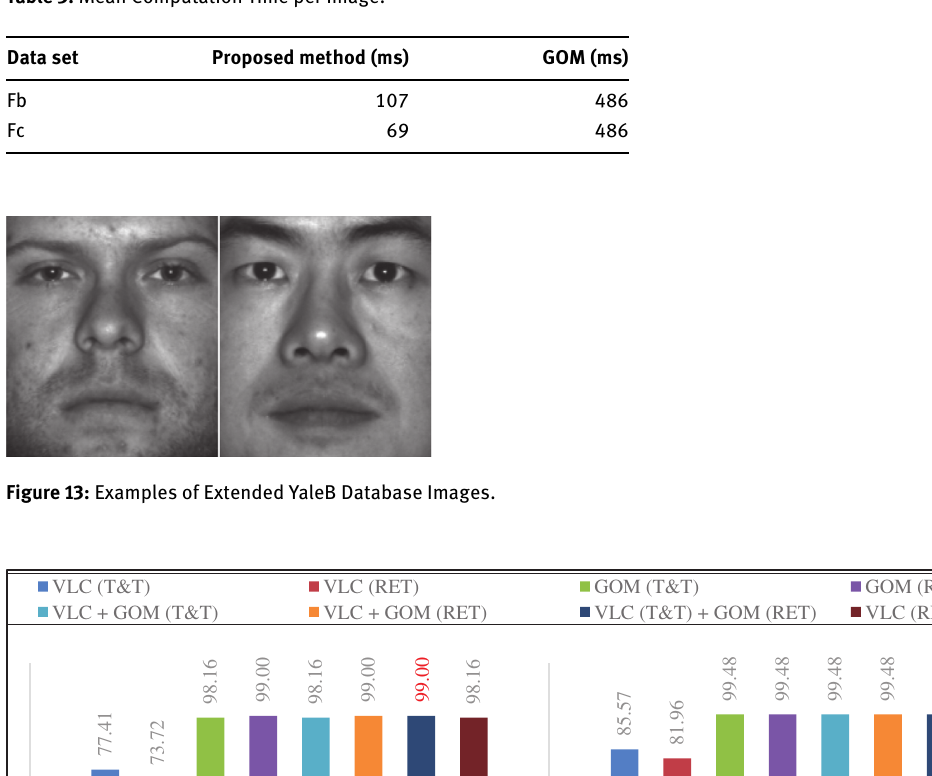
Table 3: Mean Computation Time per Image.